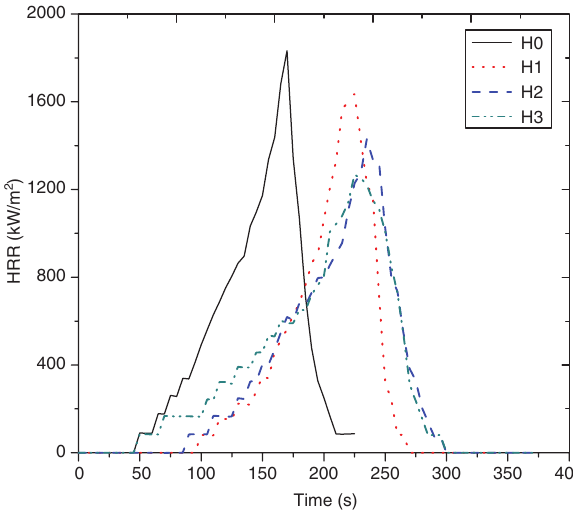
Figure 6: Heat release rate curves of neat PP (H0) and the PP/ Ni-LDH